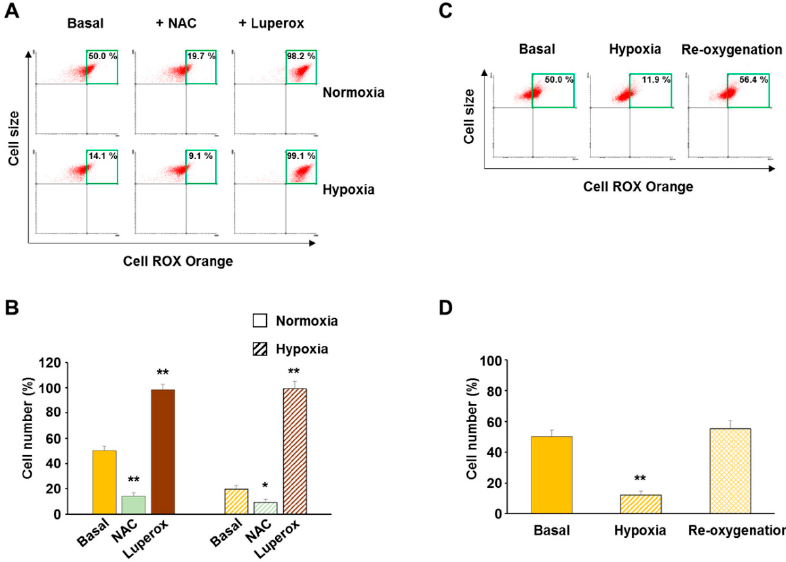
Figure 1. Validation of ROS detection by CellROX in human fibroblasts. ( A ) Typical top right quadrant (green-framed) analysis of cell fluorescence distribution as an index of ROS level. CellROX-loaded fibroblasts were analyzed following the exposure to 1 mM NAC or 200 μ M Luperox, under both normoxia and hypoxia (6 h). ( B ) Quantitation of high fluorescent cells as an index of ROS content. ( C , D ) Fluorescence of CellROX-loaded control cells exposed to 4 h hypoxia followed by 4 h re-oxygenation. Data are means ± SD of three independent experiments, each carried out on four different cell lines. * p ≤ 0.05 and ** p ≤ 0.01 indicate the statistical significance of data compared to basal conditions.